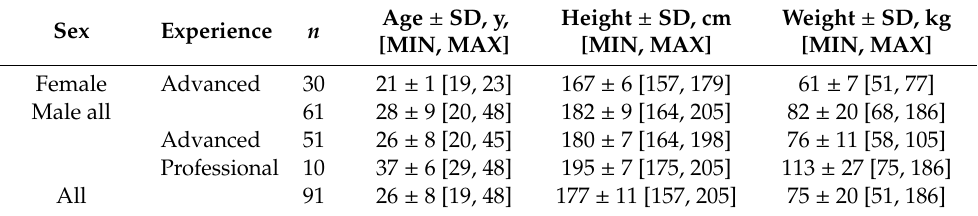
Table 1. Mean values with standard deviations of anthropometric characteristics of participants.